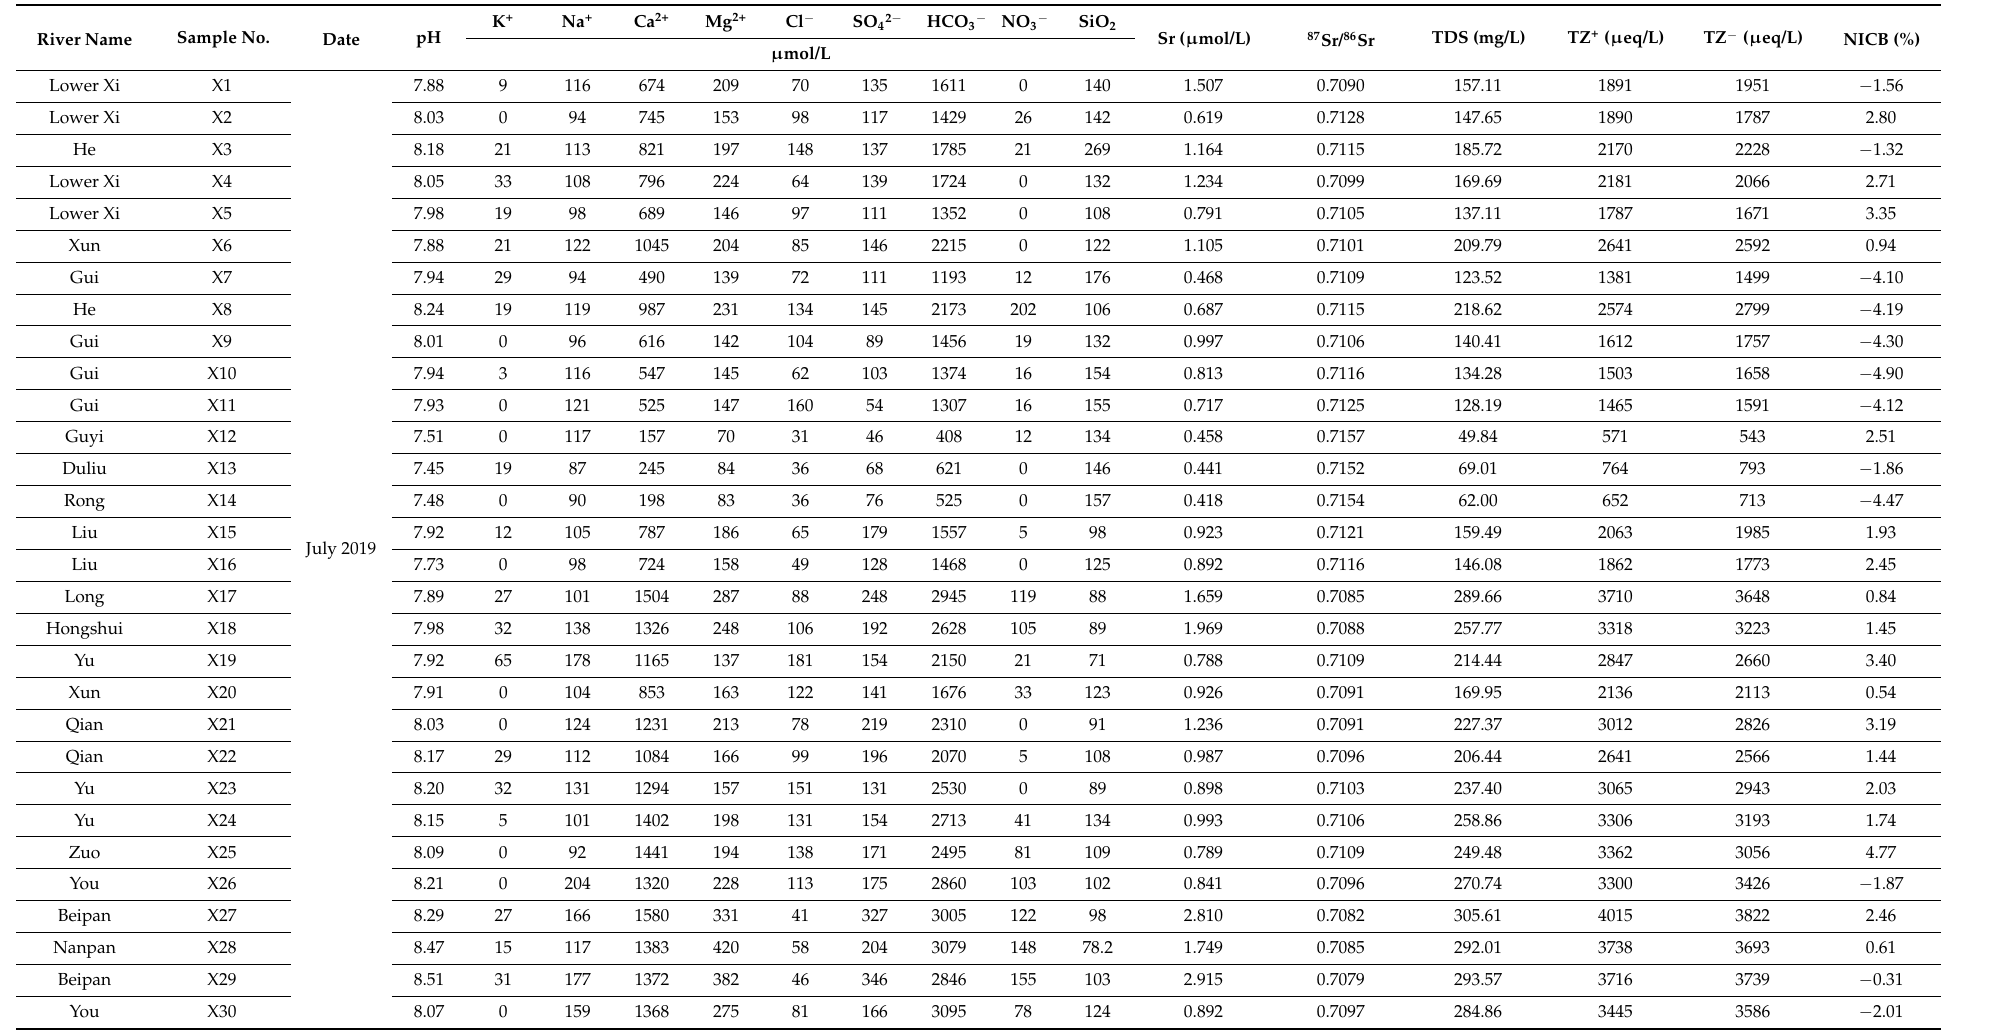
Table 1. Basic parameters and chemical compositions of the main ions at each sampling point of the main stream and tributaries of the Xi River. River